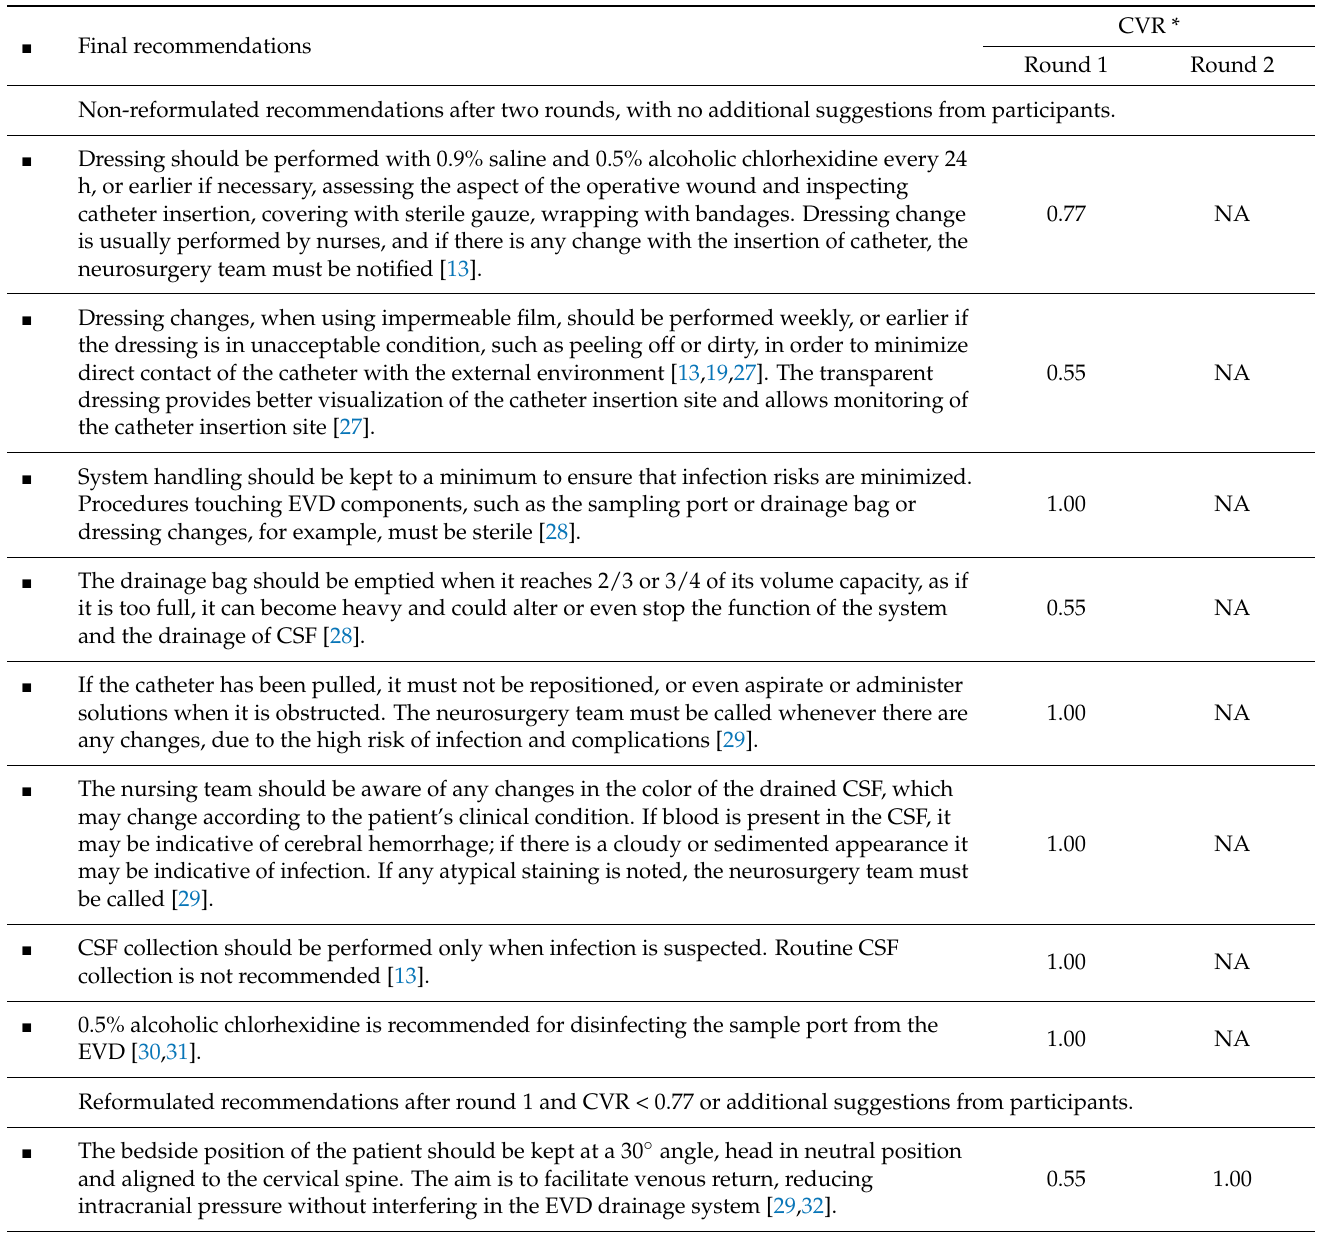
Table 1. Final recommendations after round 1 and 2 of the evaluation